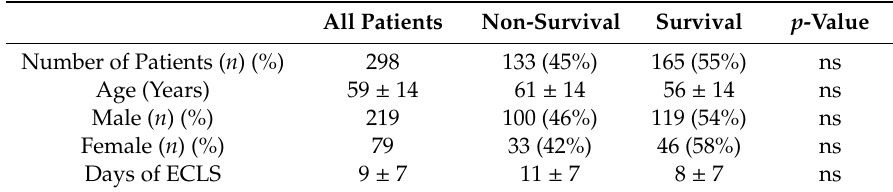
Table 1. Patient